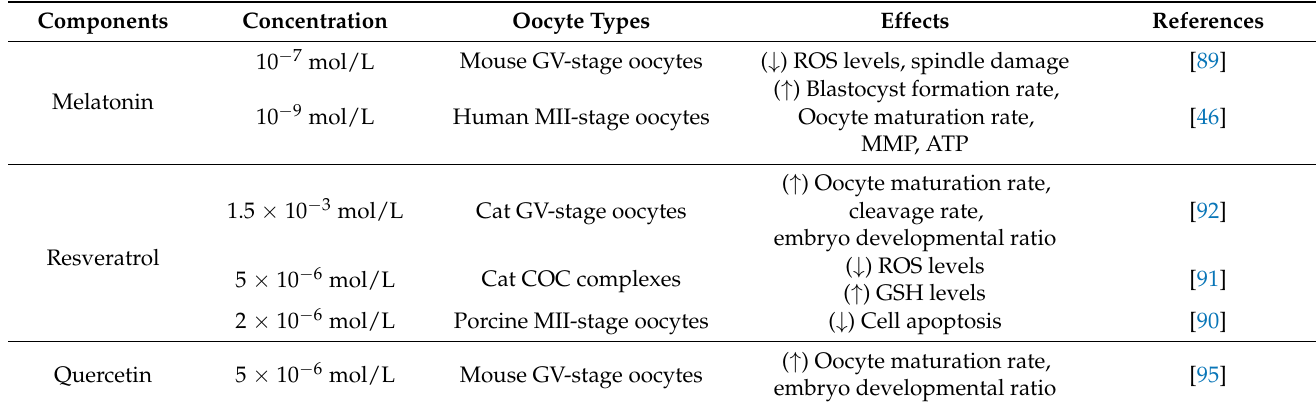
Table 1. The effects of exogenous non-enzymatic antioxidants on oocyte